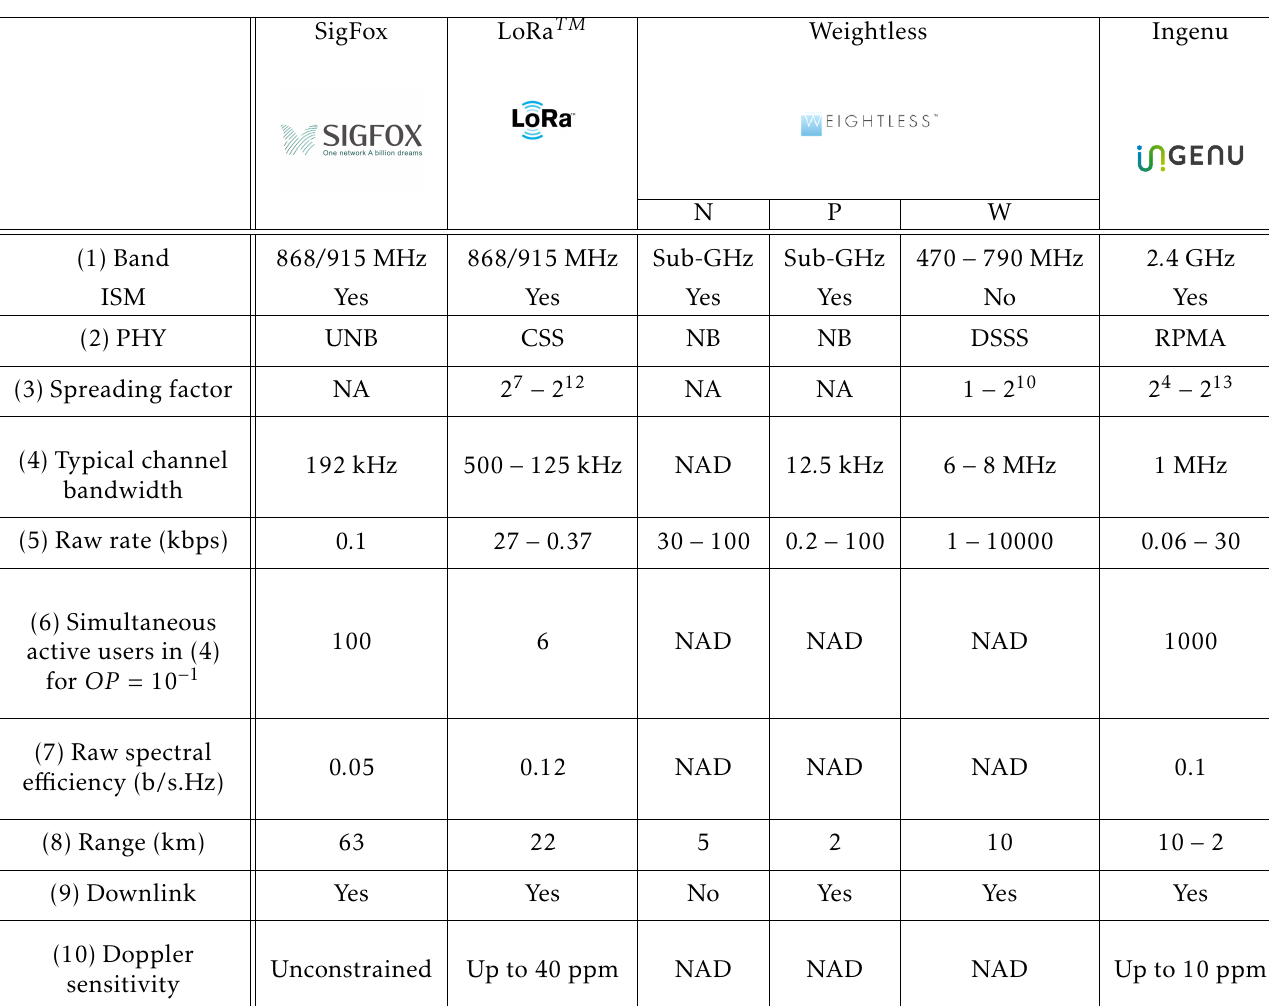
Table 2. Technologies summary and comparison (NA= Non Applicable; NAD= Non Available Data)